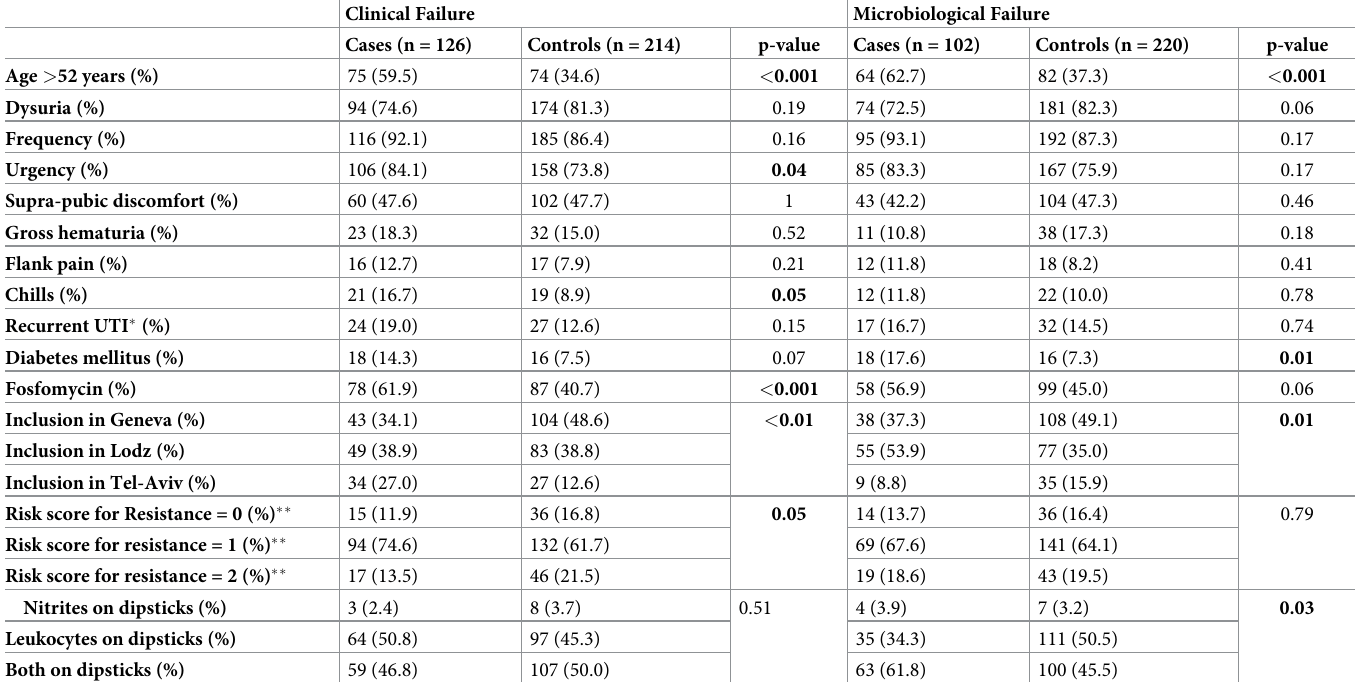
Table 1. Population characteristics.